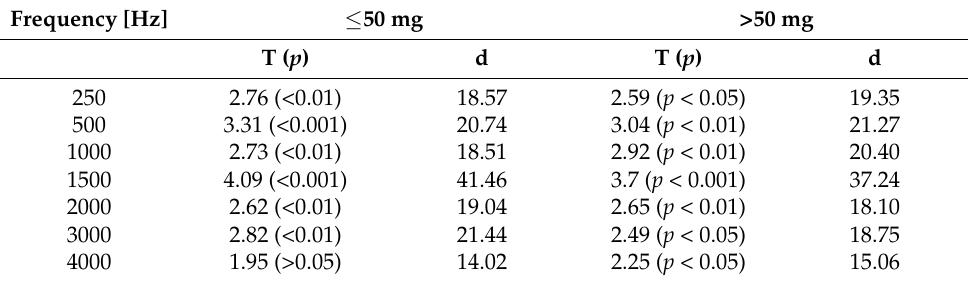
Table 4. First dose in ST vs. improvement of hearing—BC.